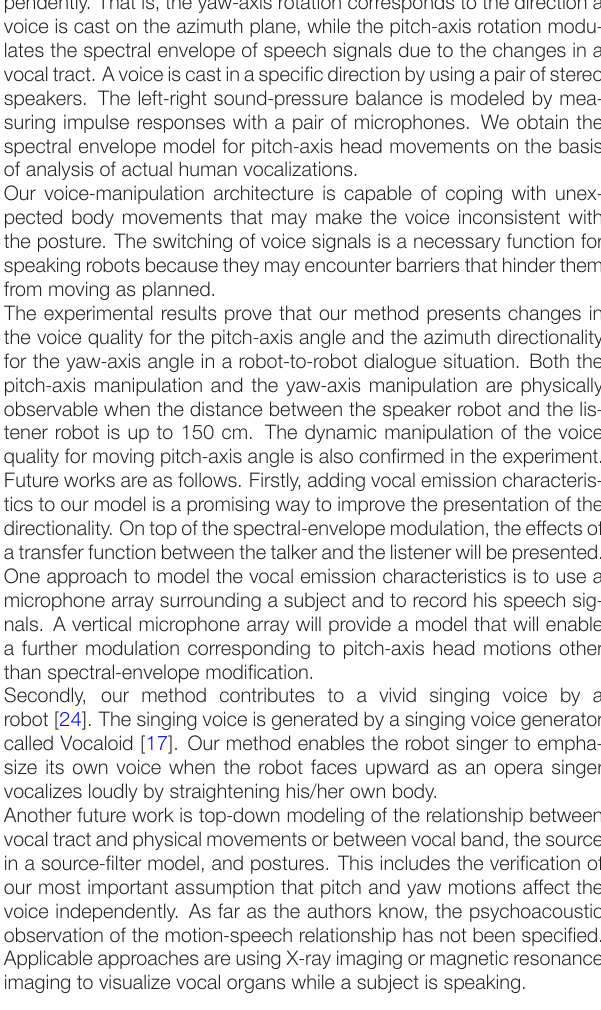
frame. The obtained gain curves contain huge fluctuations because the recorded signals contain a noise caused by caused by the connec- tion of microphones or in the environment. Since the rough shape of these curves represents how the original voice signal is amplified with regard to its pitch angle, the fluctuations due to a noise should be ig- nored. Therefore, the curves are put through low-pass filter to reduce the noise from the gain